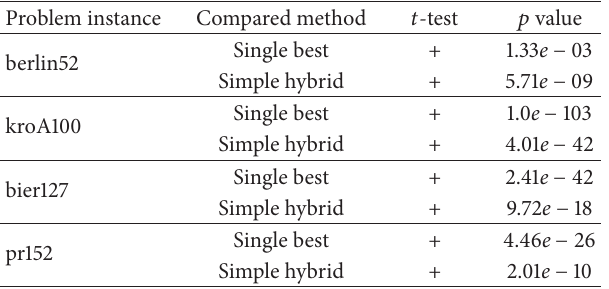
Table 3: Statistical test of TSP.